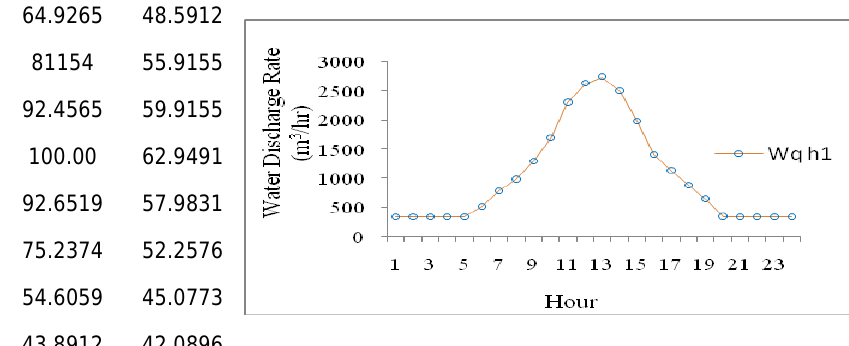
Figure 4. Hourly water discharge rate Table 5. ensures that the generation cost for one hydro unit and three thermal units obtained by ALR technique.